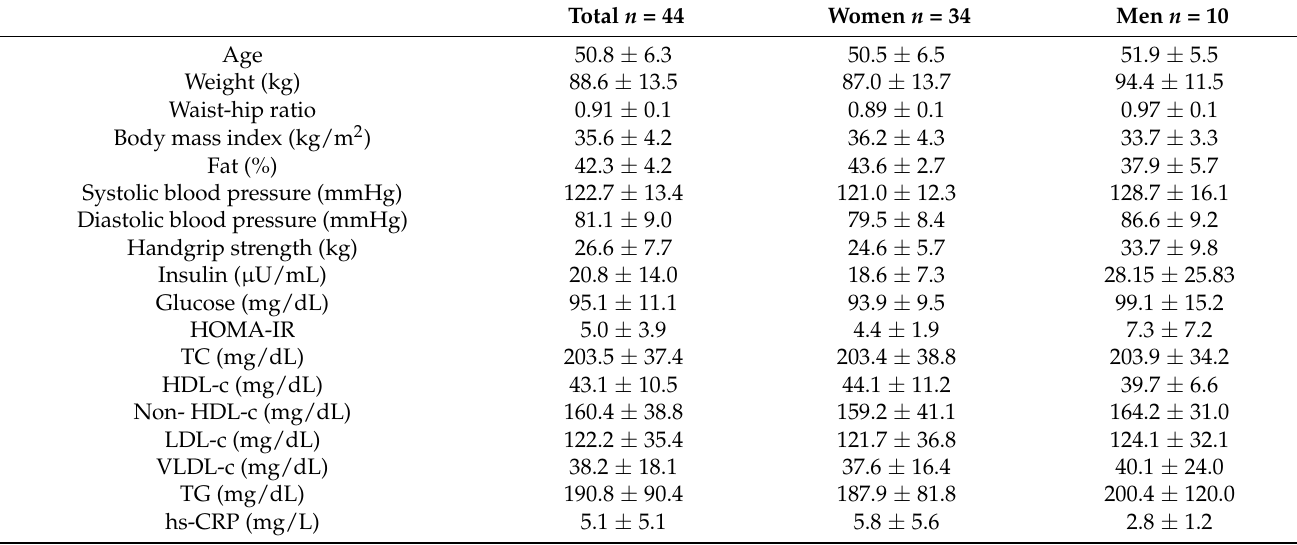
Table 1. Baseline characteristics of the patients included in the study before any dietary intervention.